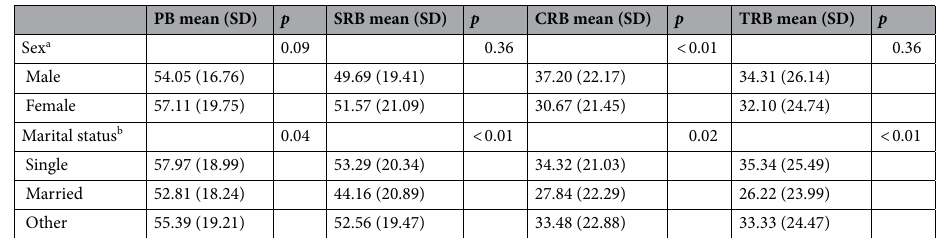
Table 2. Comparison of the mean of the CBI dimensions according to sociodemographic characteristics. a t-test; b